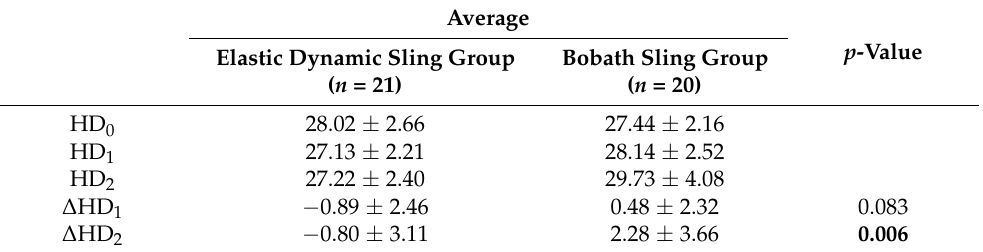
Table 3. Difference in horizontal distance between the elastic dynamic sling group and the Bobath sling